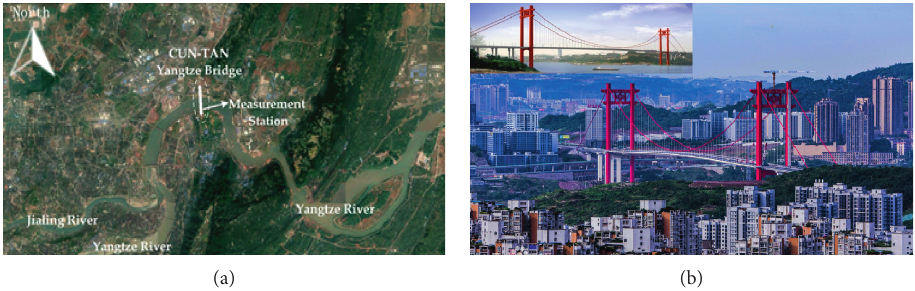
Figure 1: (a) Geographical location of the bridge. (b) Overlooking view of the bridge.